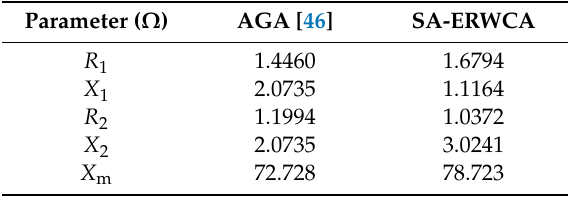
Table 22. Results for AGA and SA-ERWCA for Machine 5.